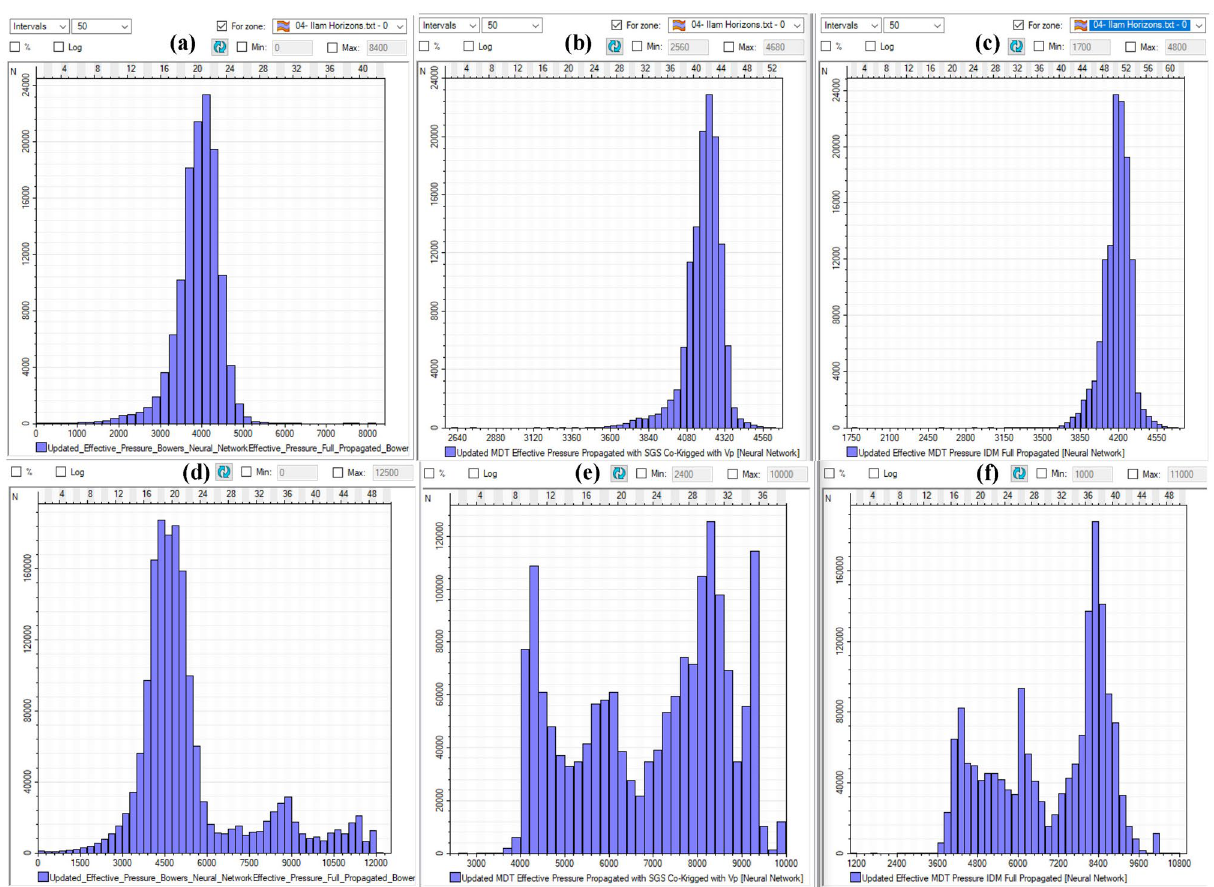
Fig. 8 Histogram comparison of the modeled effective pressure data of Ilam Formation by methods a Bowers (left column), b SGS (middle col- umn) and c IDW (right column), and d – f in the whole study field (according to the top